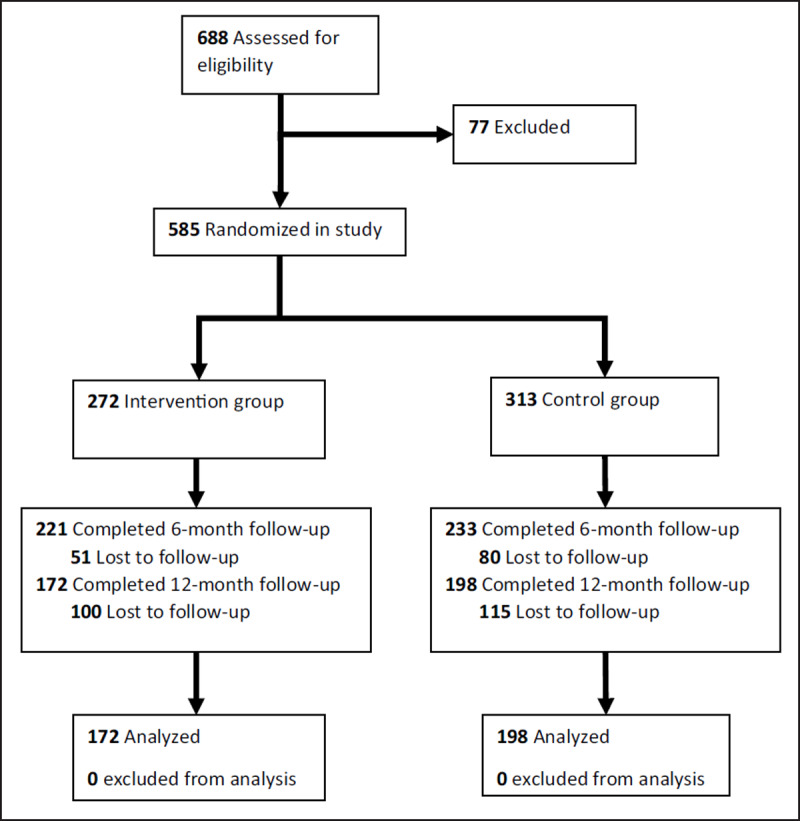
Study Flow Diagram.